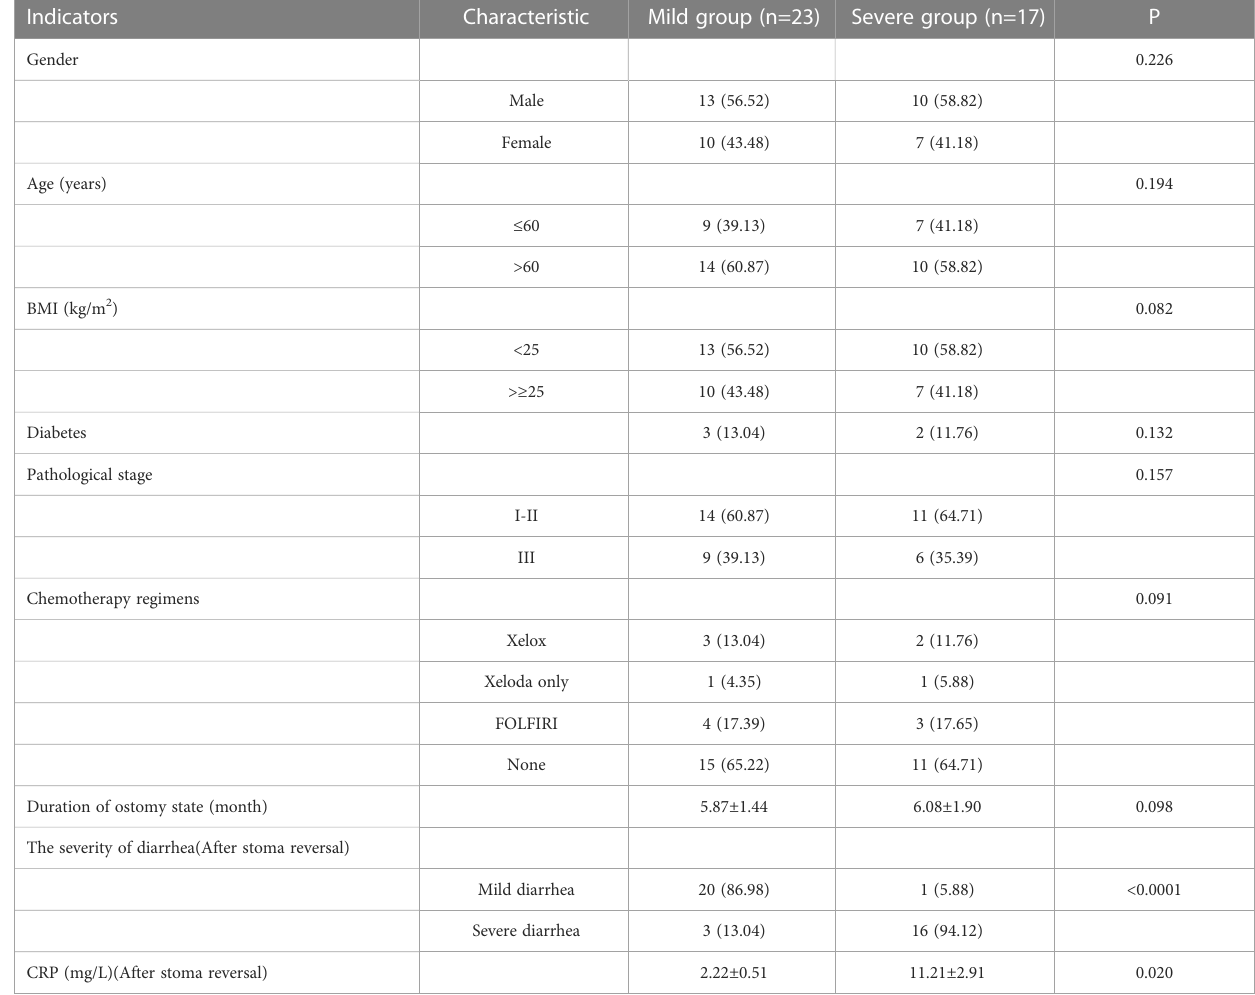
TABLE 4 Comparison of baseline data between two groups (n/%, x s